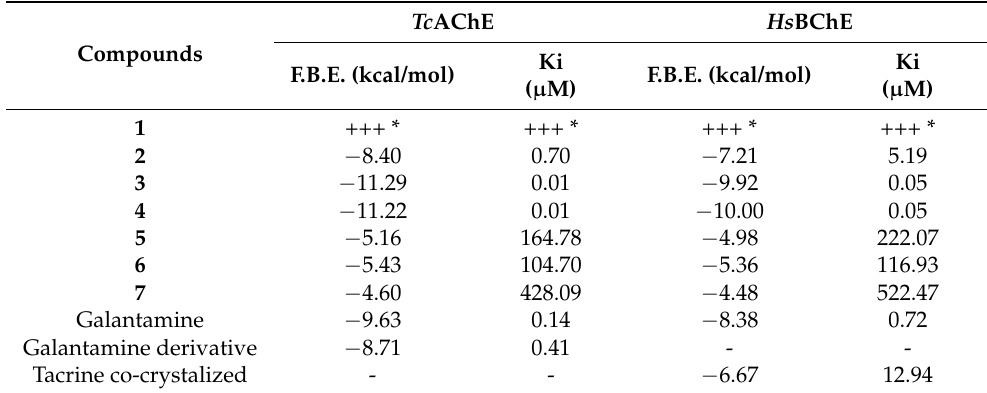
Table 5. Free binding energy (F.B.E) and the inhibition constant (Ki) values of the inhibitors and the isolated compounds ( 1–7 ) towards the enzymes ( Tc AChE and Hs BChE).